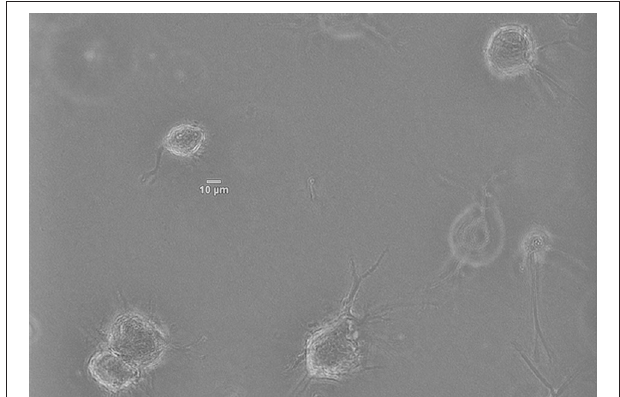
FIGURE 5 | Norman Human Dermal Fibroblast (NHDF) cultured in 3D collagen-based fibrous matrix (2 mg/ml collagen). Image was captured with a Nikon D-Eclipse Microscope with a Plan Fluor 200x magnification (20x Objective) and phase